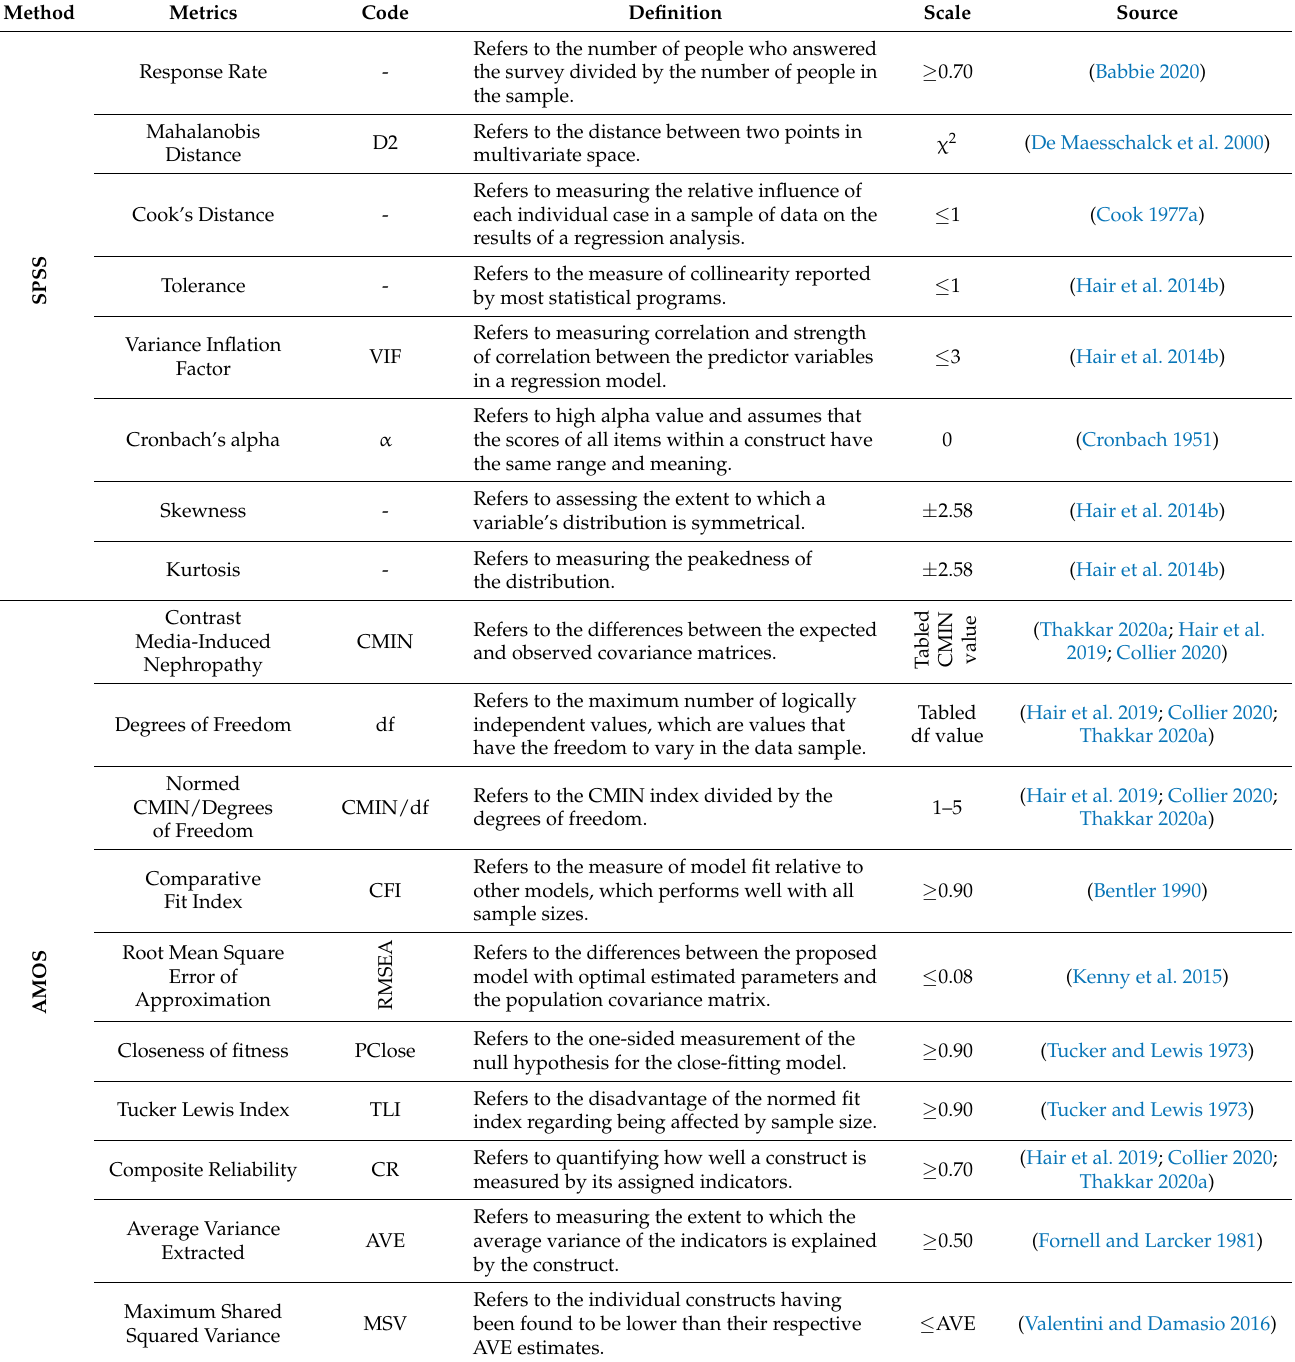
Table 2. Summary of metrics used in the present study. Own